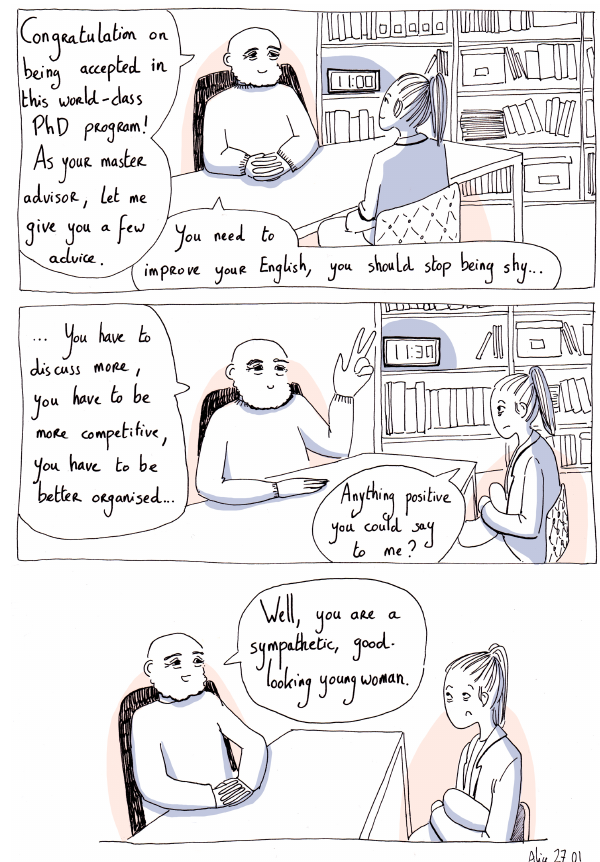
Figure 6. A female scientist finds herself isolated from the research community at a conference due to needs related to motherhood. Ex- ample of “Women as outsiders in networking contexts” stereotype. Comics title: “Breastfeeding at conferences” (DTRH team, 2019a; Adenis, 2019). All comics are hand-drawn by Alice Adenis – dis- tributed under the Creative Commons Attribution 4.0 License.